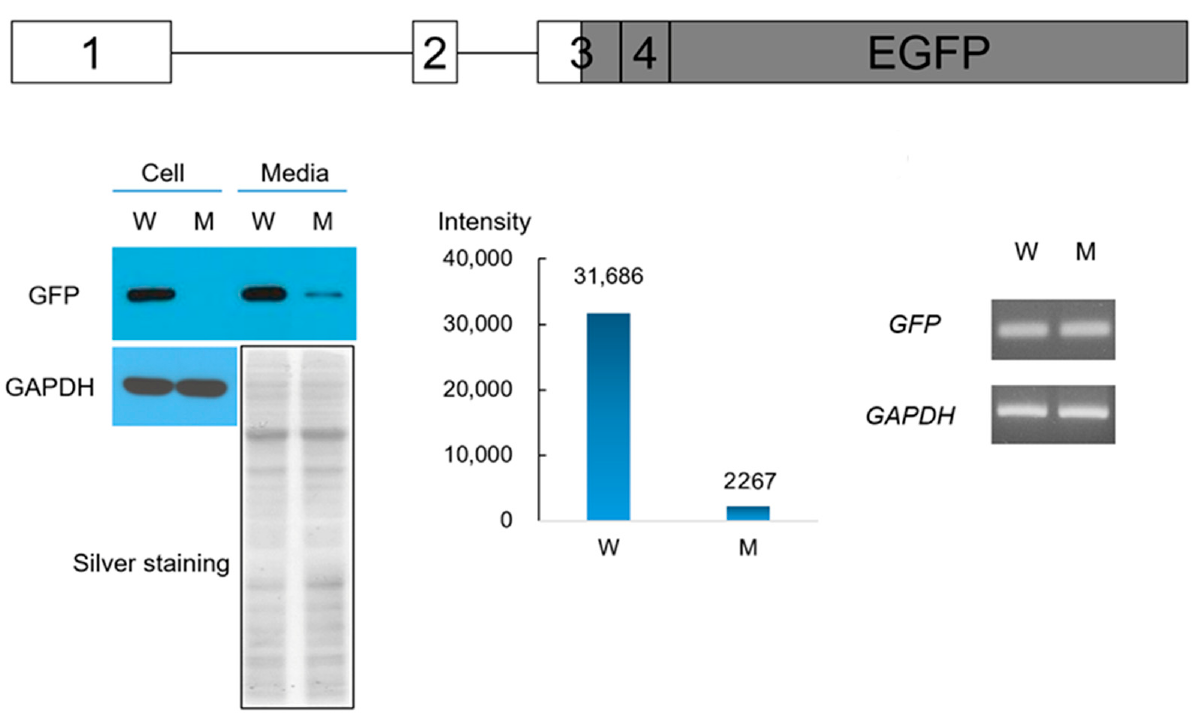
Figure 3. Western blot and RT-PCR of gene expression assay. HEK293 cells were transfected with the wild-type and mutant proteins tagged with C-terminal GFP expressing vectors. A diagram of the gene fragment in the vector is shown above. Coding exons and EGFP encoding sequences are shown with grey color in the boxes. Western blot (using GFP antibody) was performed with the cell lysate and concentrated culture media. There was no detectable protein in the cell lysate transfected with the mutant vector; however, there was a reduced expression in the culture media transfected with the mutant vector. Western blot using GAPDH antibody and silver staining of the gel were provided as positive control and for normalization. The band intensities in the culture media were measured and displayed as a bar chart. ROI values are shown above the bars. Agarose gel images of PCR products are shown on the right side. W: wild-type, M: